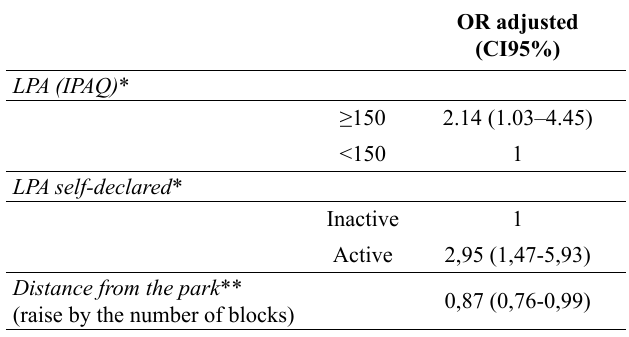
Table 3. Adjusted association between the level of physical activity in leisure estimated by IPAQ, the level of self-declared physical activ - ity, distance from the Sport and Culture Park and the intention to use it for physical activity in adults (Uruguaiana/RS,